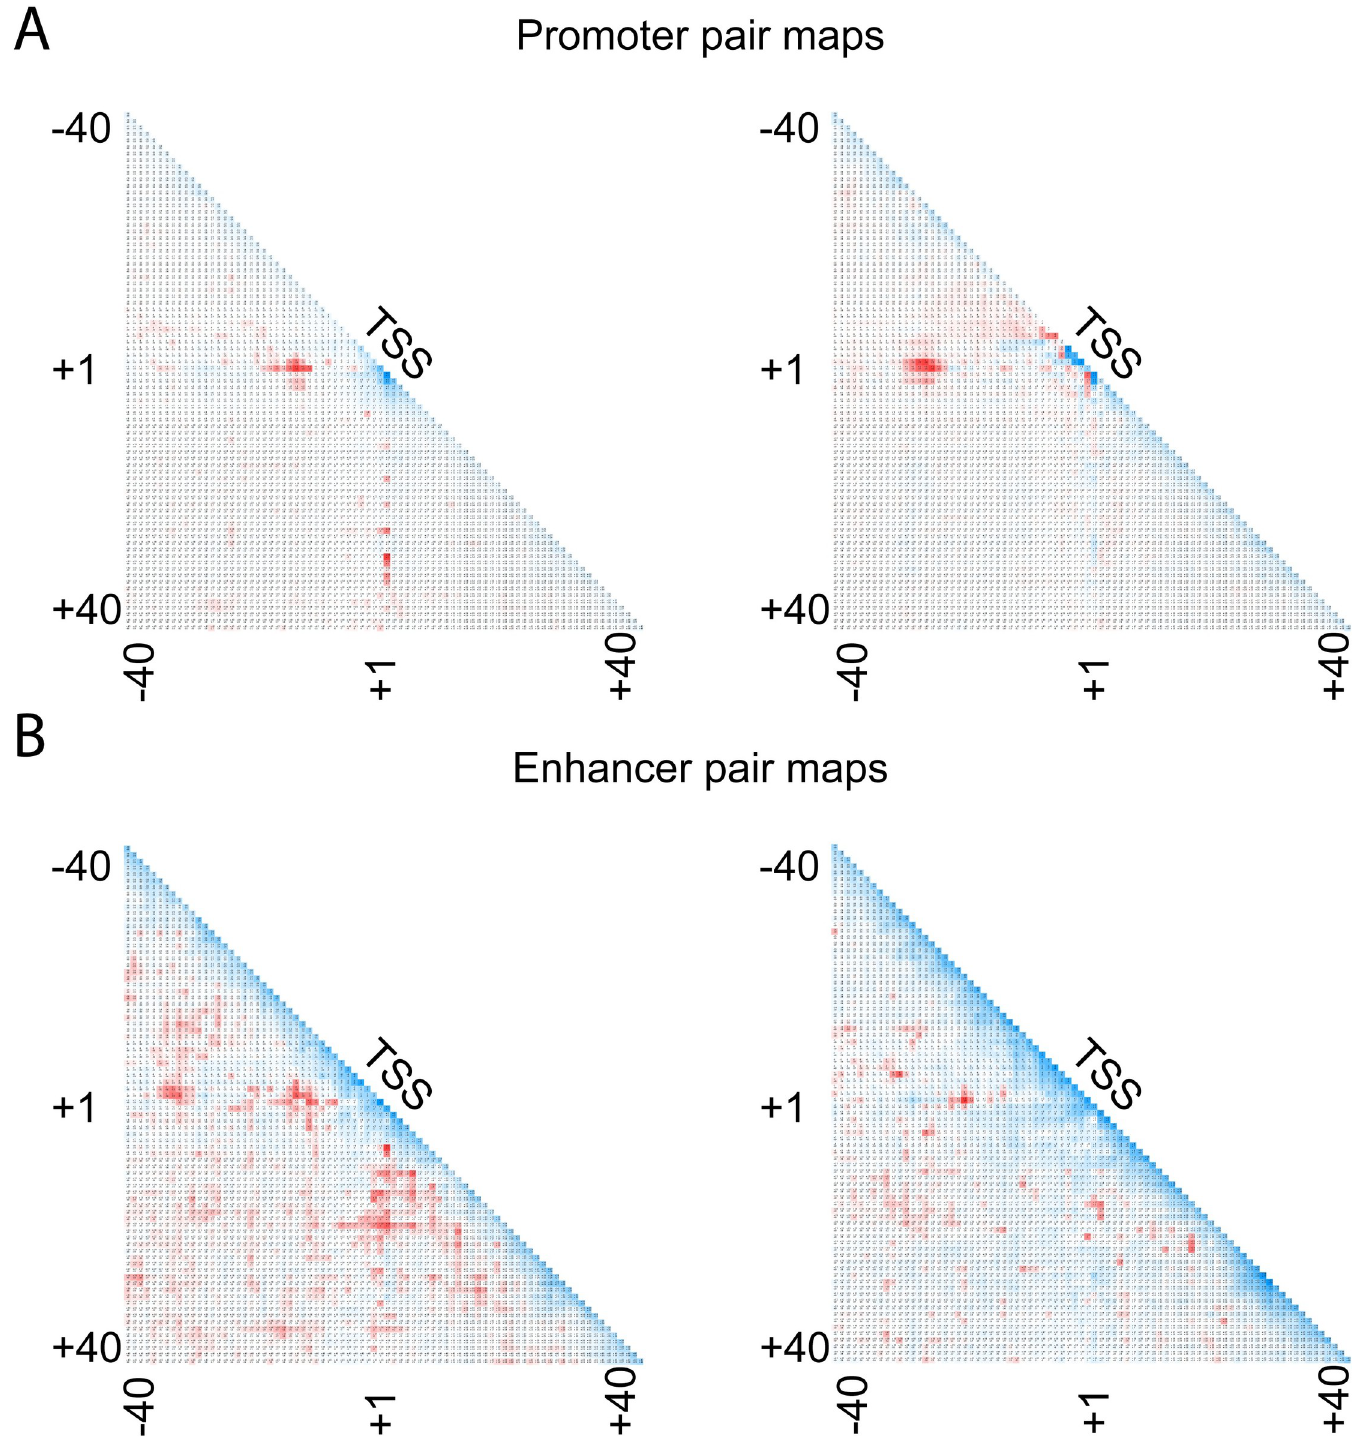
Fig 5. Pair dependency map reveals long-range interactions captured by our model. The red color means interaction, the blue color shows correlation, and the white color represents that the positions are independent. The results are clustered into ten groups using k-means algorithm and the two biggest groups are shown. ( A ): Promoter pair maps show relationships between conserved promoter elements, which have much stronger interactions than other pairs. They include TSS interactions with TATA and BRE elements in the upstream region, DCE and DPE elements in the downstream region. ( B ): Dependencies captured by our model for predicting enhancers are spread out in the [-40: +40] region. Unlike promoter sequences, there are no strong short-range interactions in the TSS region.